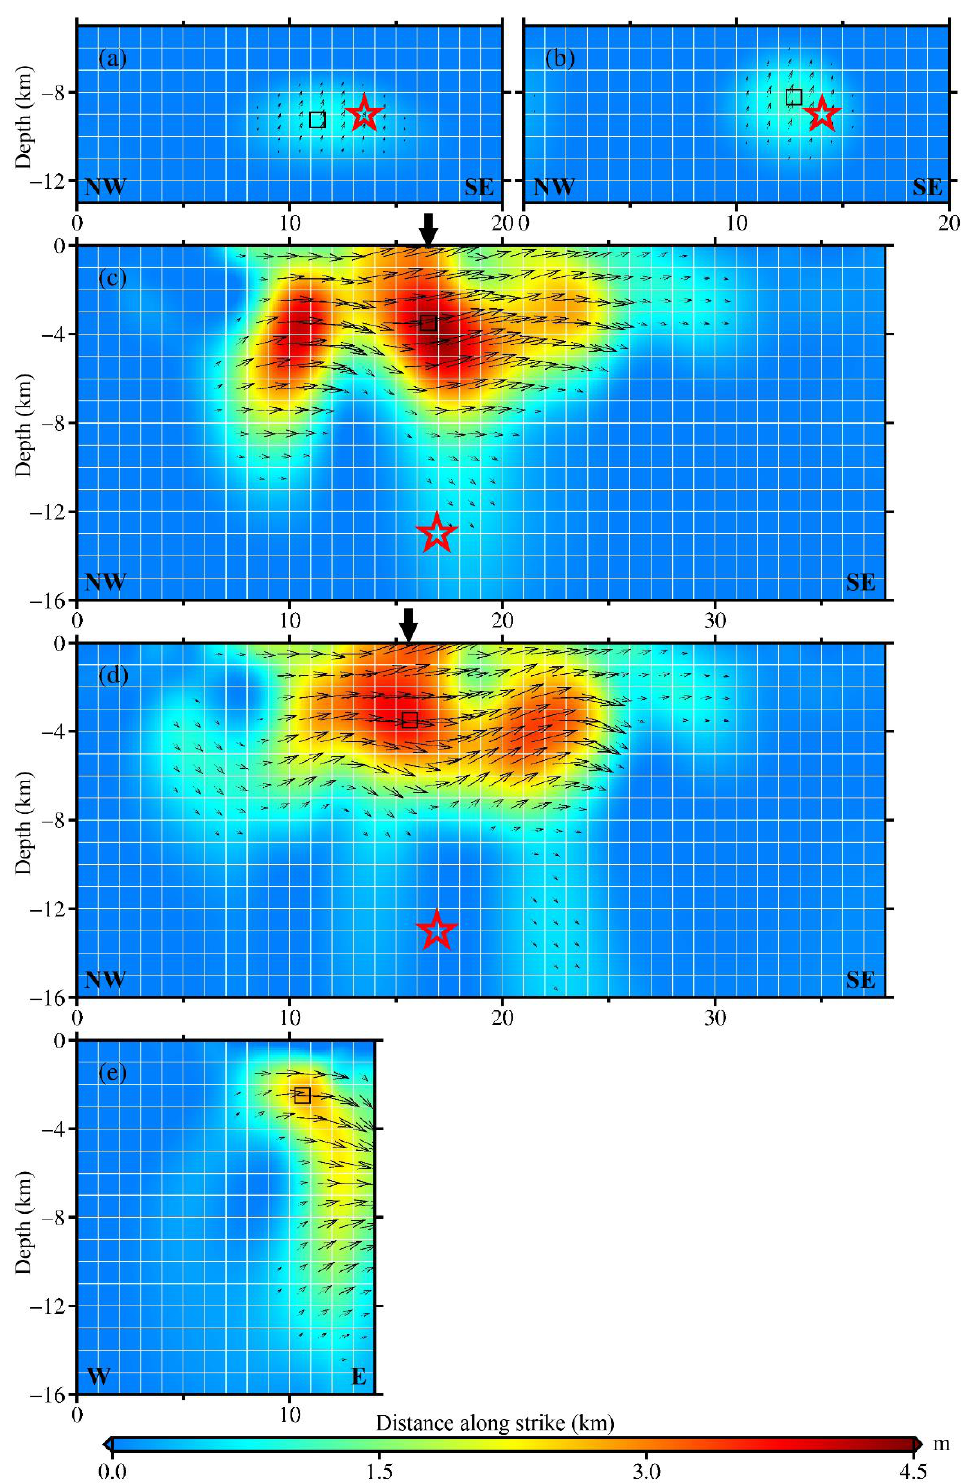
Figure 6. Sip distribution of the 2016 and 2022 Menyuan earthquakes. ( a , b ) the resultant slip distribution of the 2016 earthquake using MYDMYF and NLLLF as the candidate causative fault, respectively. ( c ) the inverted slip distribution of the 2022 earthquake for the one-fault model. ( d , e ) the resolved slip distribution of the 2022 earthquake for the two-fault model. Red star denotes the epicenter from the USGS. Black squares mark the location with the maximum slip. The black arrow shows the location with maximum near-surface slip.